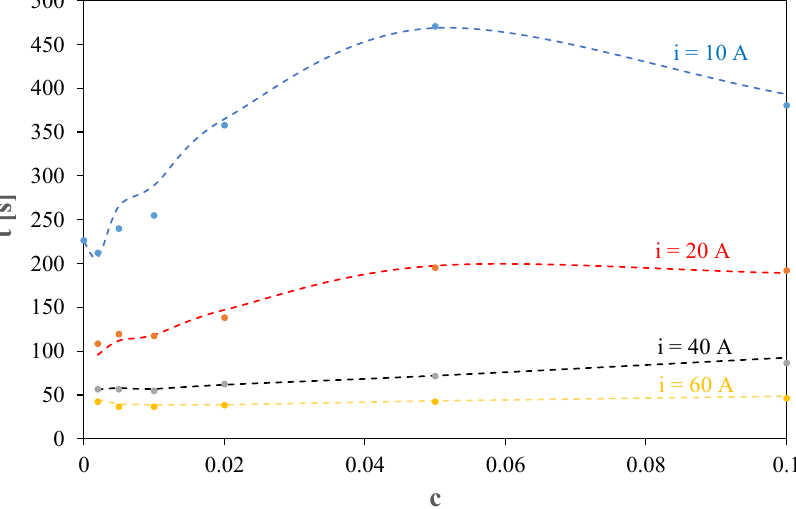
obtained at a concentration of c = 0.01 for high values of current. At lower values of current,